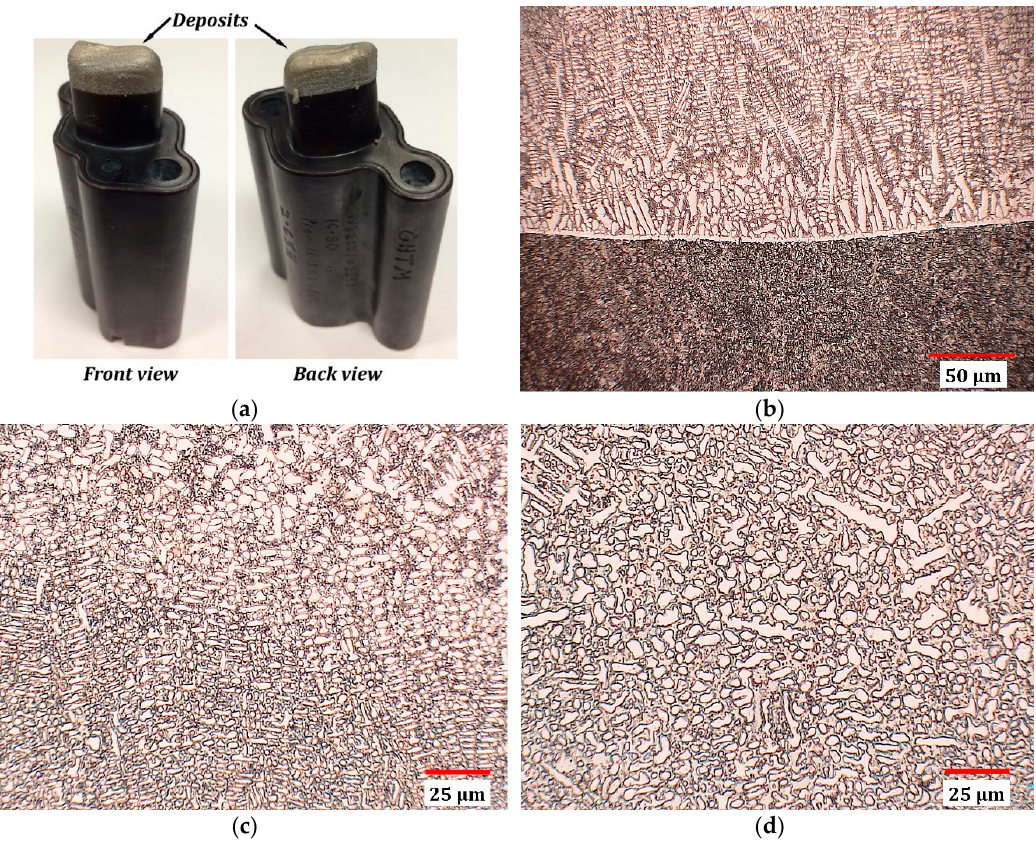
Figure 16. ( a ) Damaged part after repair; optical micrographs of materials at the interface ( b ), in the middle layers of deposits ( c ) and on the top layers of deposits ( d ).